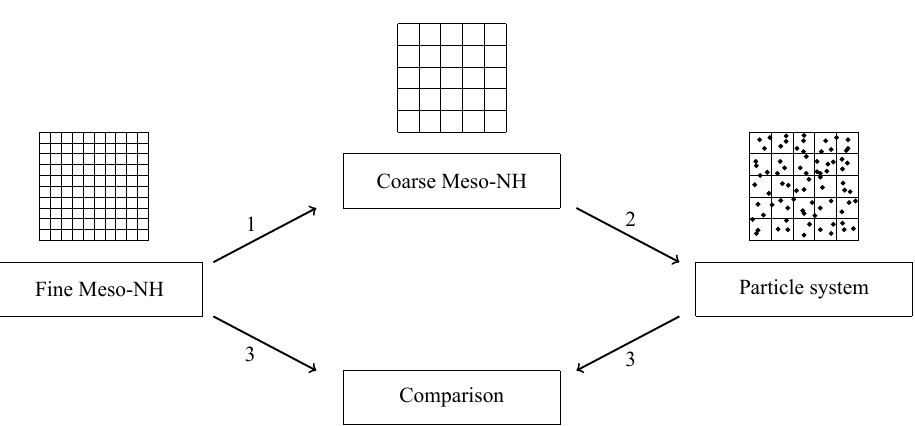
Figure 2. Our study framework. We use a high-resolution model, which is averaged to obtain a coarse field. Particles are forced with coarse fields, and then fine fields are compared to particle